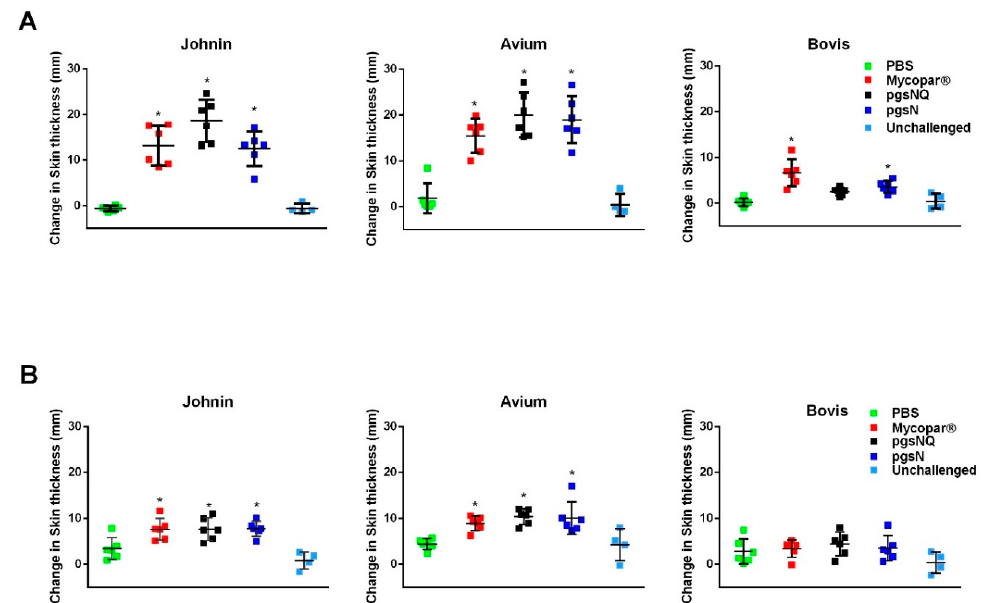
Figure 3. Vaccine induced delayed type hypersensitivity in calf groups. Intradermal skin test performed on calves at 2 months post vaccination ( A ), and 12 months post challenge ( B ). Each graph shows the di ff erence of pre injection skin thickness measurement (0 h) from the skin thickness measurement 72 h after purified protein derivatives (PPD) injection. Each data point represents an individual animal, while the horizontal lines indicate the mean value for each group with error bars representing the standard deviation; * p < 0.05 compared to the PBS group. The 0 h skin thickness was subtracted from the 72-h skin thickness prior to statistical analysis.